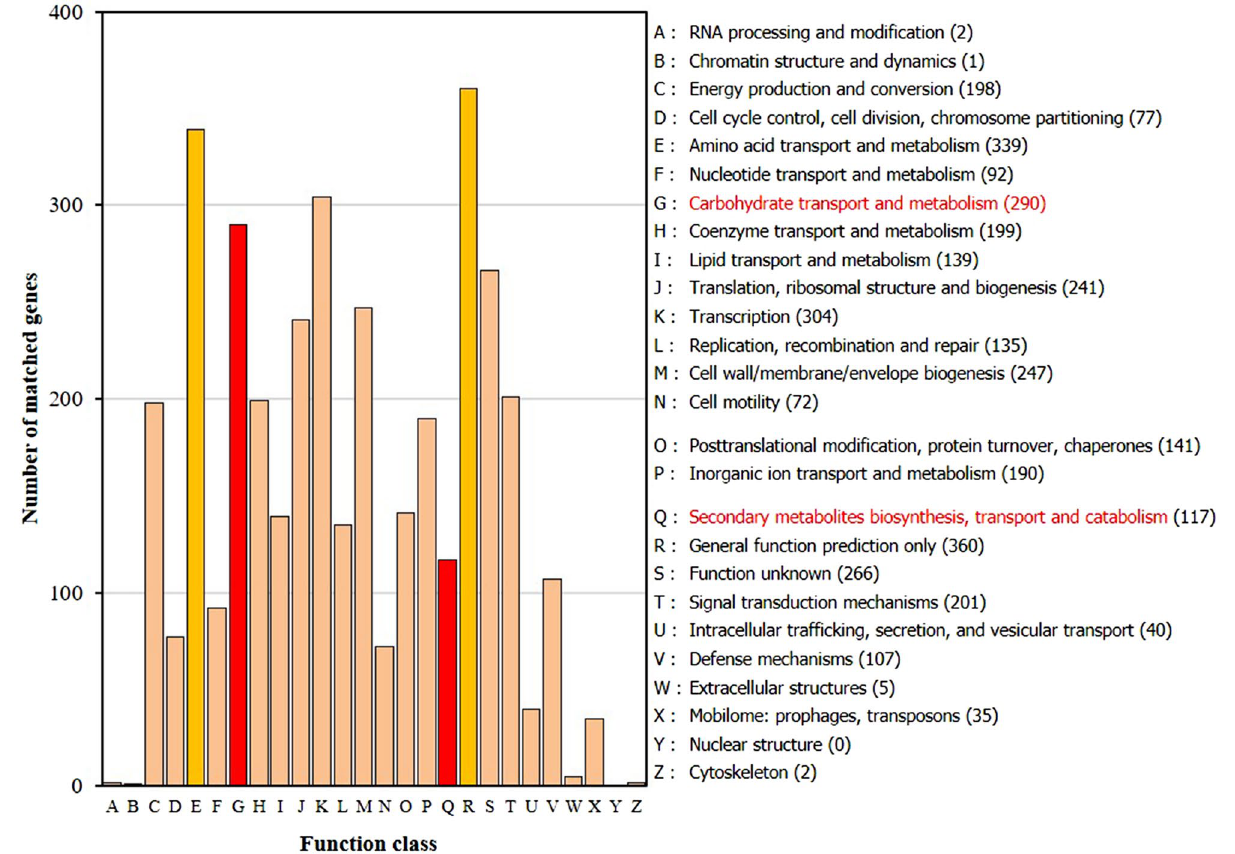
Figure 5. The COG function annotation of Bacillus velezensis AK-0. Distribution of genes in different COG function